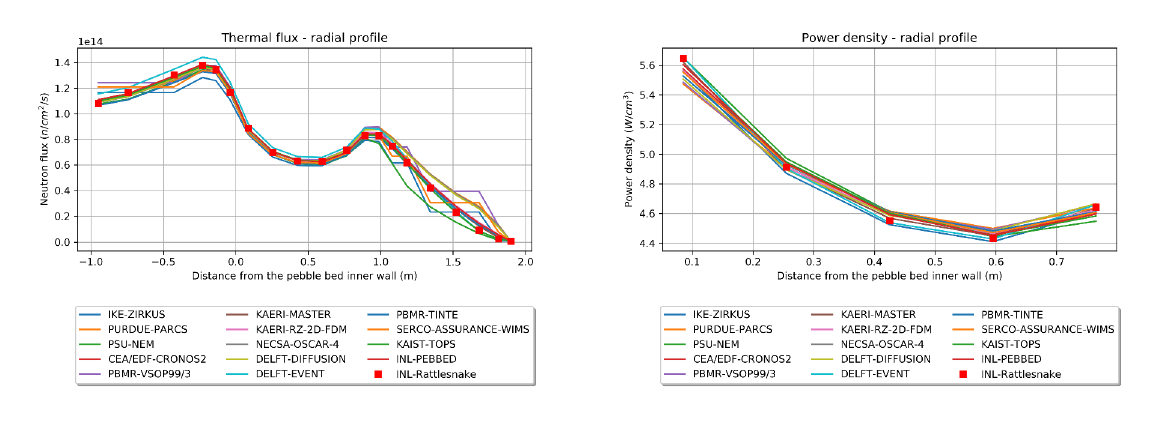
Figure 8: Thermal Flux - Radial Profile Comparison